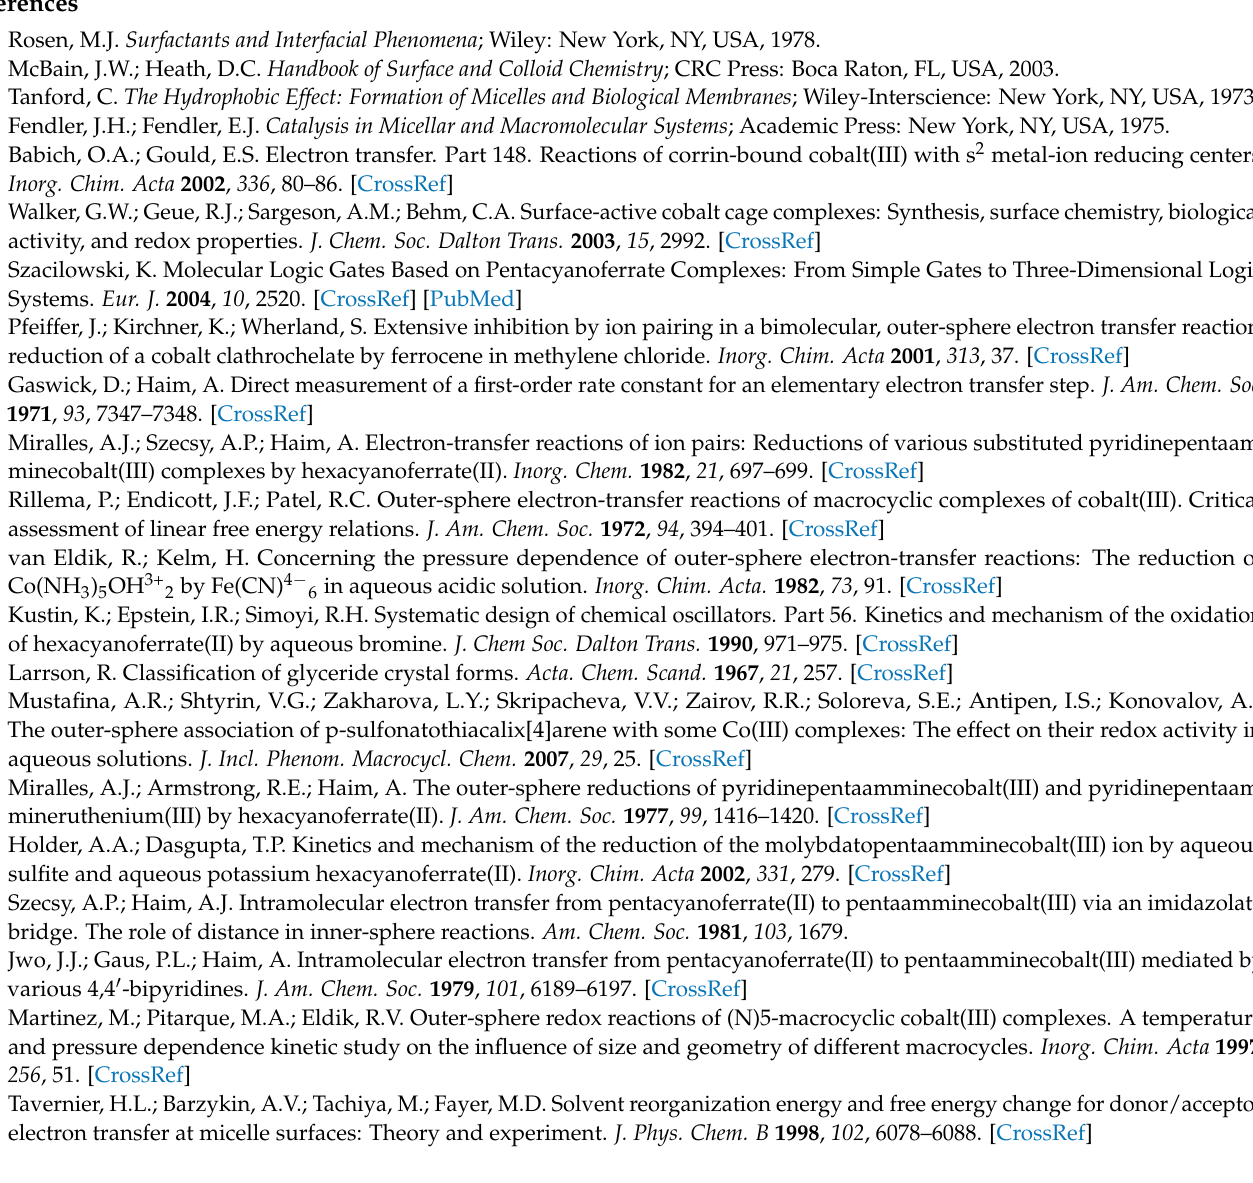
medium; Table S8: Activation parameters for the reduction of Cis-[Co(dpqc) 2 (C 12 H 25 NH 2 ) 2 ](ClO 4 ) 3 , µ = 1.0 moldm − 3 in [BMIM]Br